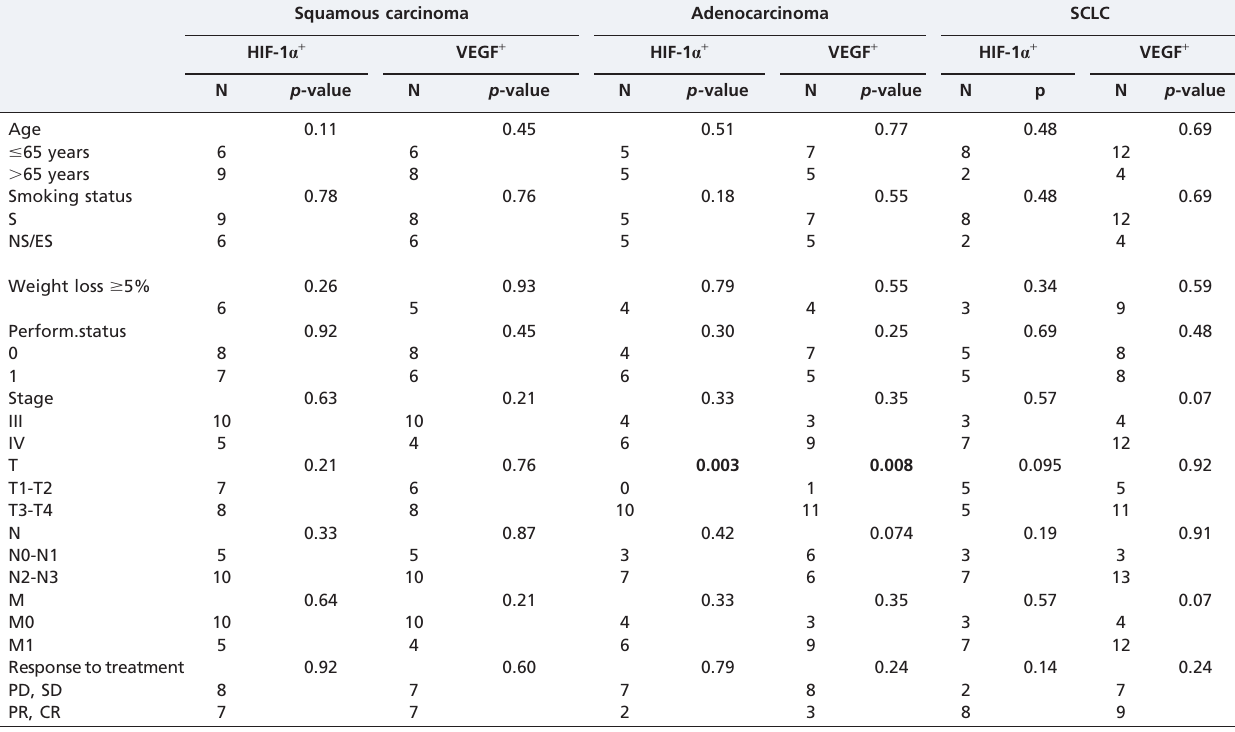
Table 2 - The relationships between HIF-1 a and VEGF expression and clinicopathologic factors in three types of lung